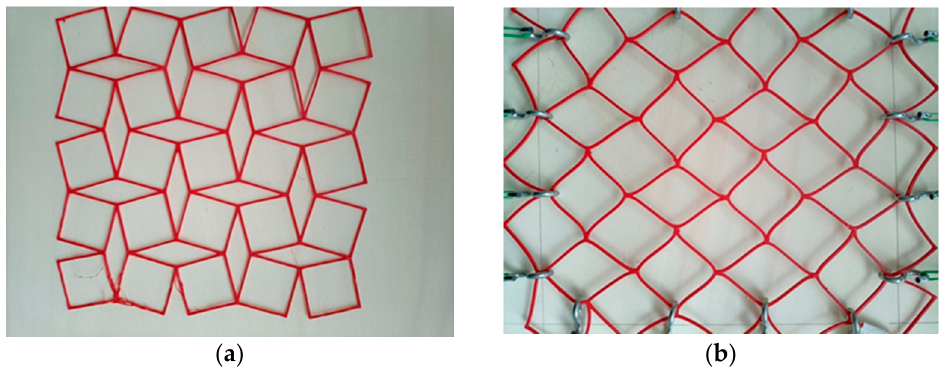
Figure 9. “Mesh” structure made of soft polymer in initial position ( a ) and after stretching in two perpendicular directions ( b ).